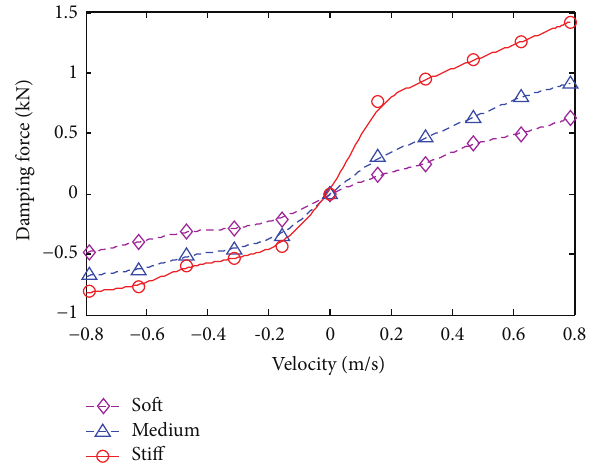
Figure 7: Characteristics of adjustable shock absorber on different damping state.